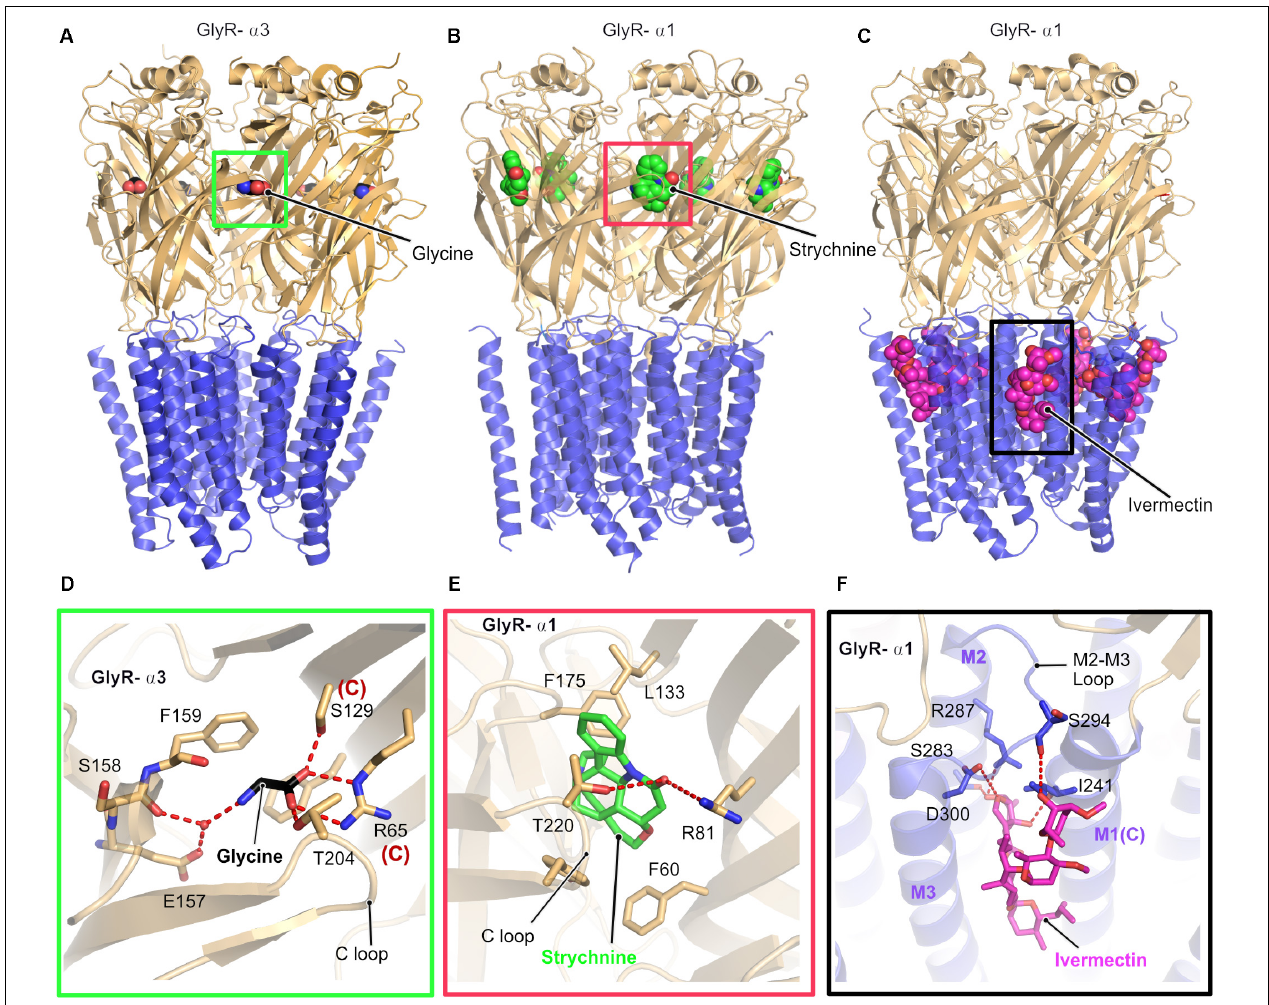
FIGURE 2 | Architecture of glycine receptors. (A–C) Cartoon representation of the overall architecture of the homopentameric α 3 GlyR in complex with glycine elucidated by X-ray crystallography ( A , PDB: 5TIN) as well as the α 1 GlyR in complex with strychnine ( B , PDB: 3JAD) and ivermectin ( C , PBD: 3JAF) by cryo-EM. The ECD is colored in light orange and the TMD in blue, bound ligands are shown in space filling representation. Enlarged views of the ligand binding pocket of the agonist glycine (black, D ), the antagonist strychnine (green, E ) and the positive allosteric modulator ivermectin (magenta, F ). Bound ligands and critical residues which mediate the binding of the molecules are displayed in stick